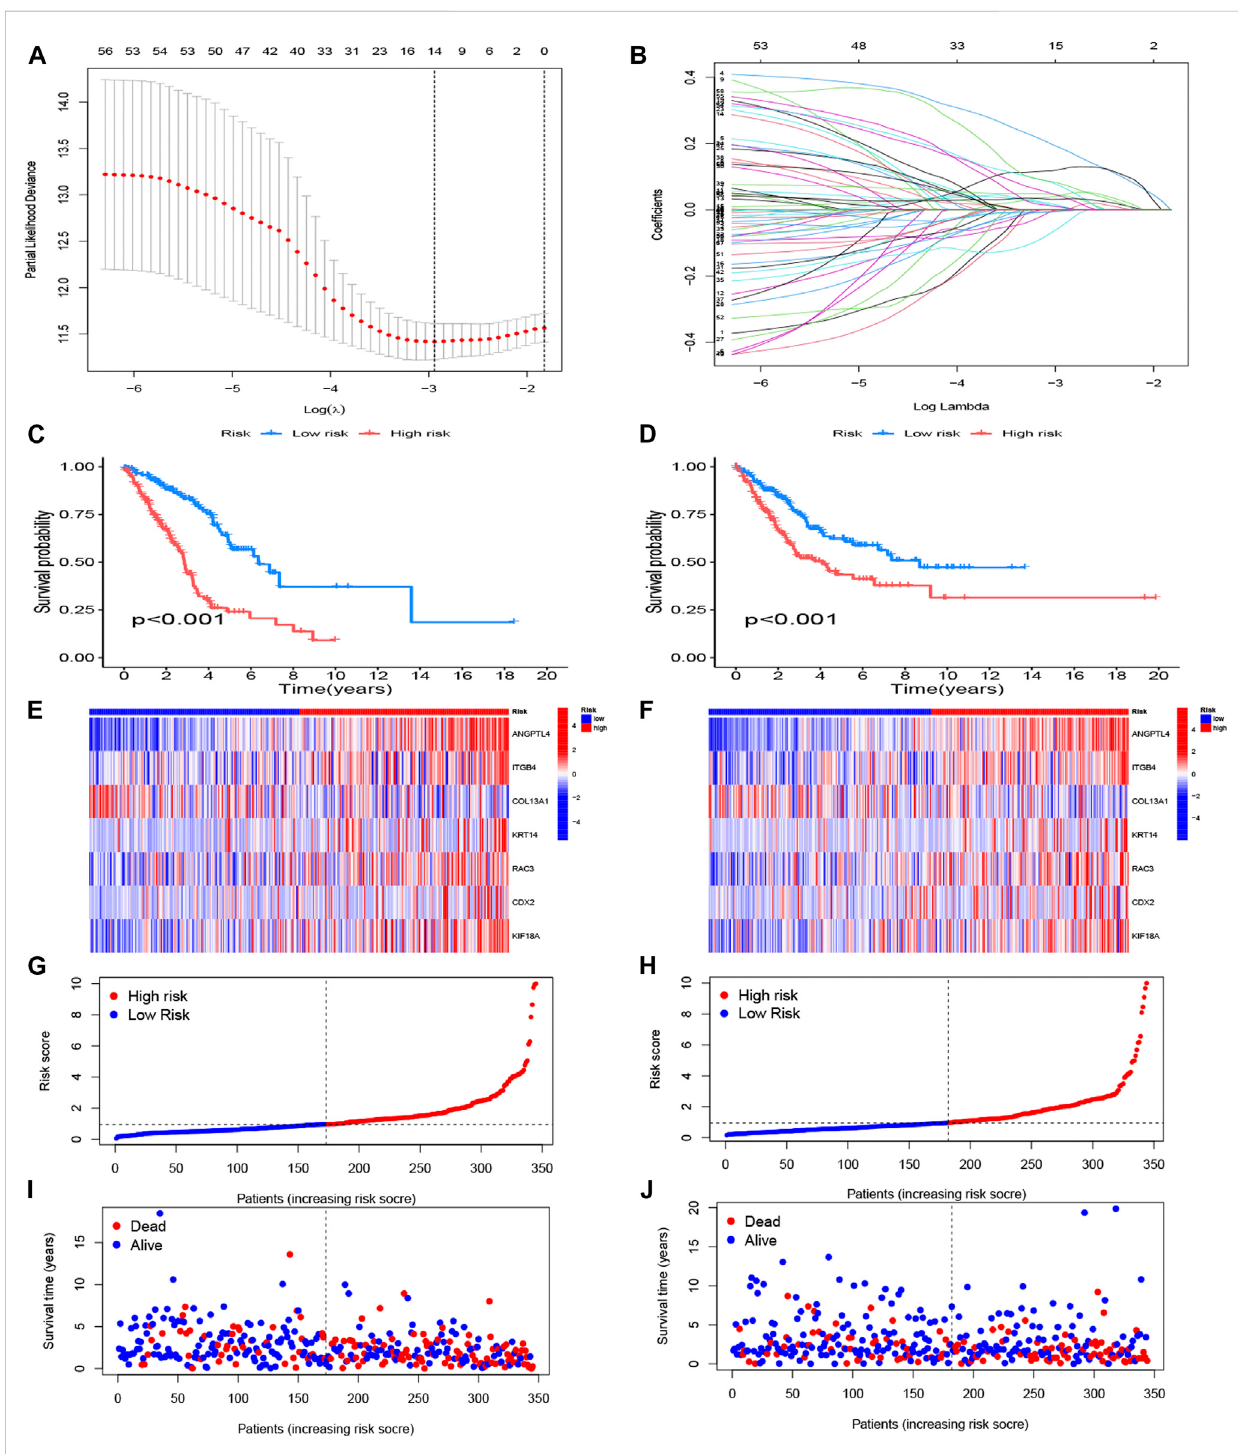
FIGURE 4 Construction of anoikis-related risk model. (A) The point of minimum error was picked out by vertical dotted line based on LASSO cross validation. (B) Dynamic process diagram of Lasso fi ltering variables. (C, E, G, I) Survival analysis and exposure rating of the training cohort. K-M survival analysis in training cohort (C) .Riskheatmap oftraining cohort indicatedthat sixover-expressed ARGs inhigh-risk group,whereastheothers overexpressedinlow- risk group (E) . Training cohort risk curve distinguished subgroups according to the median values (G) . Survival scatter diagram re fl ected a relationship between the risk score and survival time (I) . (D, F, H, J) Survival analysis and exposure rating of the testing cohort, utilizing K-M survival curve (D) , risk heatmap (F) , risk curve (H) , survival scatter diagram (J) . The signi fi cance criteria were set as p -value <